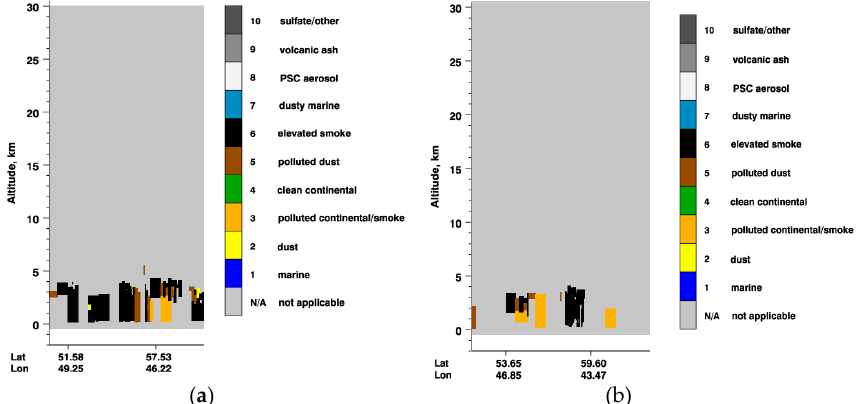
Figure 11. Analysis of CALIPSO satellite data to determine the type of aerosol for 8 August 2022 ( a ) and 27 July 2022 ( b ).